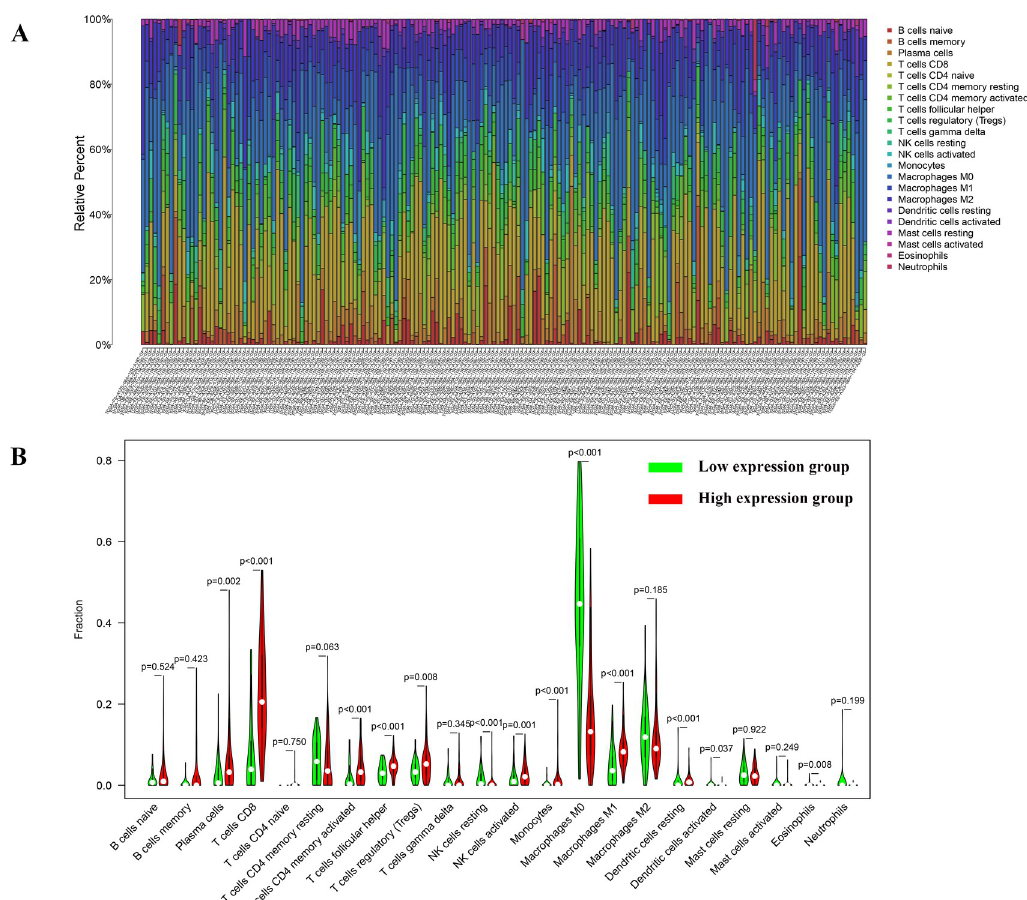
Fig 8. TIC abundance profiles in the CM samples and differentiation analysis between the expression level of HLA-DRB1 and the content of immune cells. (A) Barplot displayed the ratio of 22 kinds of TICs in different CM samples. The abscissa of the barplot is the sample ID and the ordinate is the abundance of each TIC. (B) The violin plot depicted the differences in the ratio of 22 types of TICs between the high HLA-DRB1 expression group and low HLA-DRB1 expression